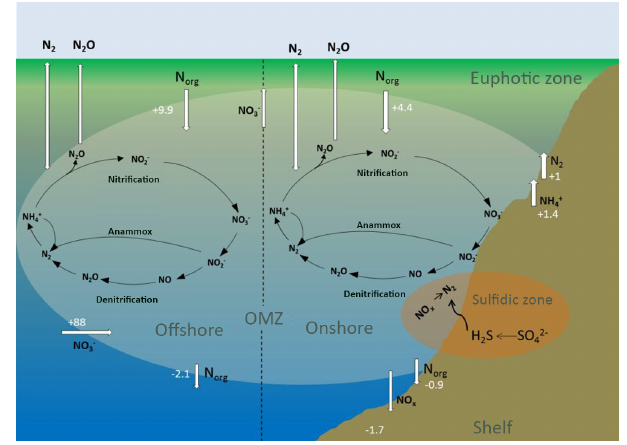
Figure 3. The marine nitrogen (N) cycle with the major onshore and offshore processes in the ETSP OMZ, modified from Kalvelage et al. (2013). Numbers indicate fluxes of N (Tgyr − 1